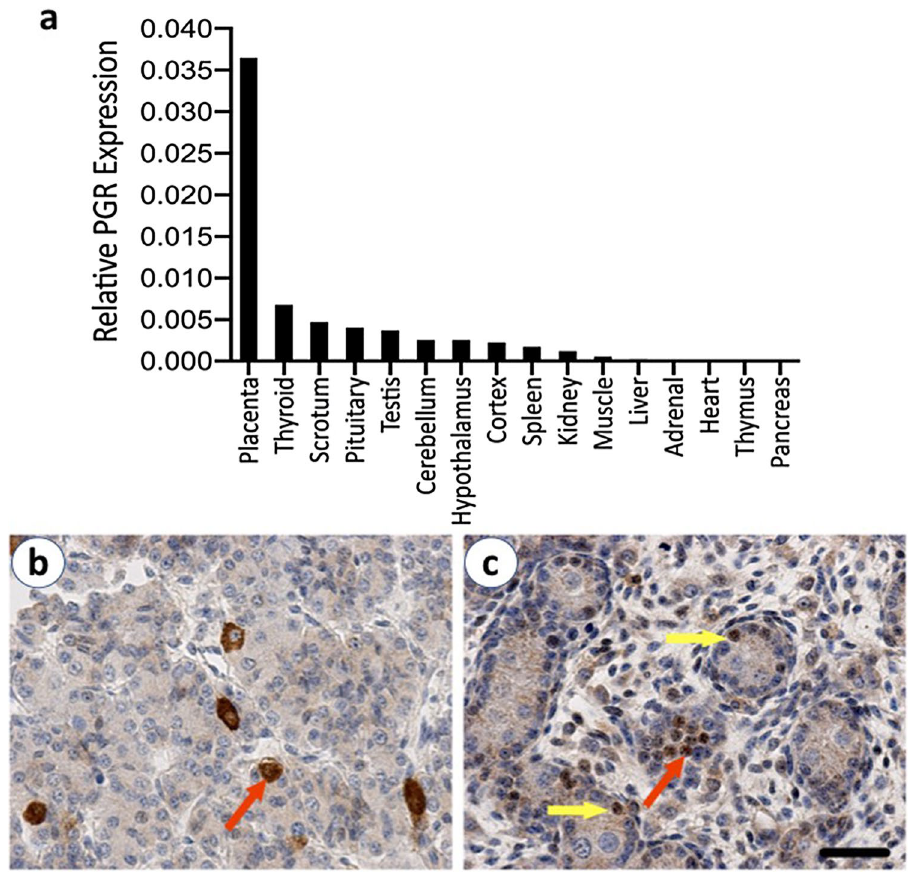
Figure 3. The expression of progesterone receptors in the male fetus at d75 gestation. ( a ) PGR transcript abundance in various fetal tissues in a control male fetus. ( b ) Immunolocalisation of PGR (brown–red arrow) to individual cells in a representative control male fetal pituitary at d75 gestation. ( c ) Immunolocalisation of PGR (brown) to Sertoli cells (yellow arrows) and fetal Leydig cells (red arrow) in a representative control fetal testis at d75 gestation. Scale bar = 50 µm.